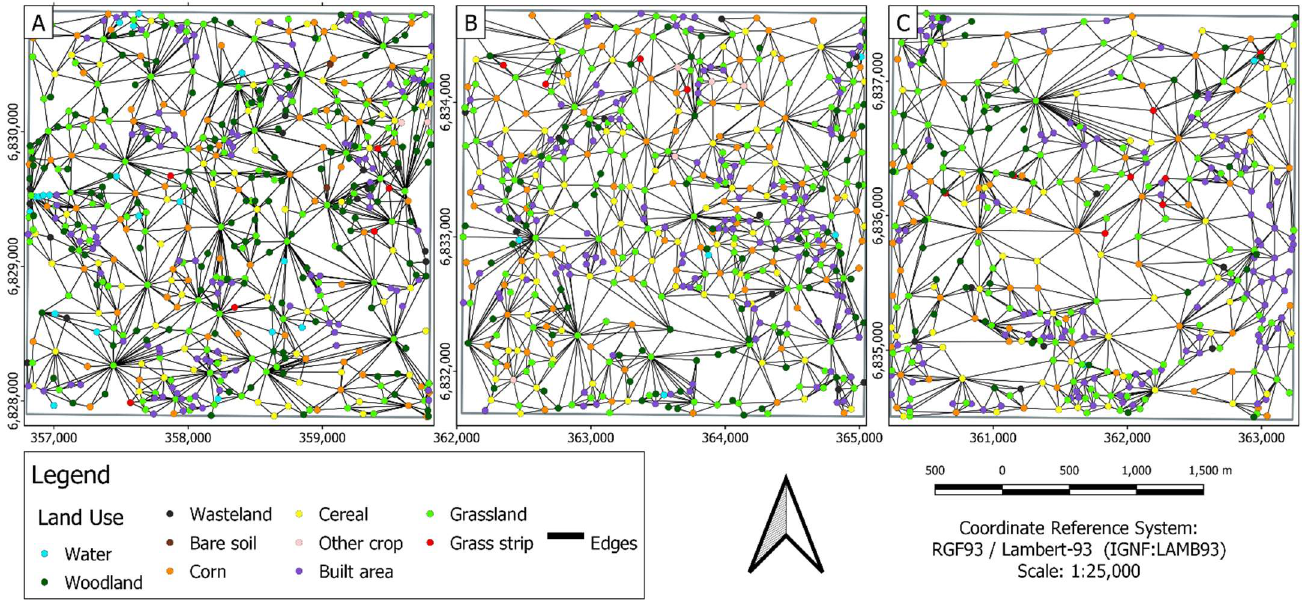
Figure 2. Graphs representing the landscapes ( A – C ) in the Zone Atelier Armorique. Different node colors represent different land uses in the patches. Several differences are evident in the characteristics of each graph: the number of nodes and edges are the most notable.